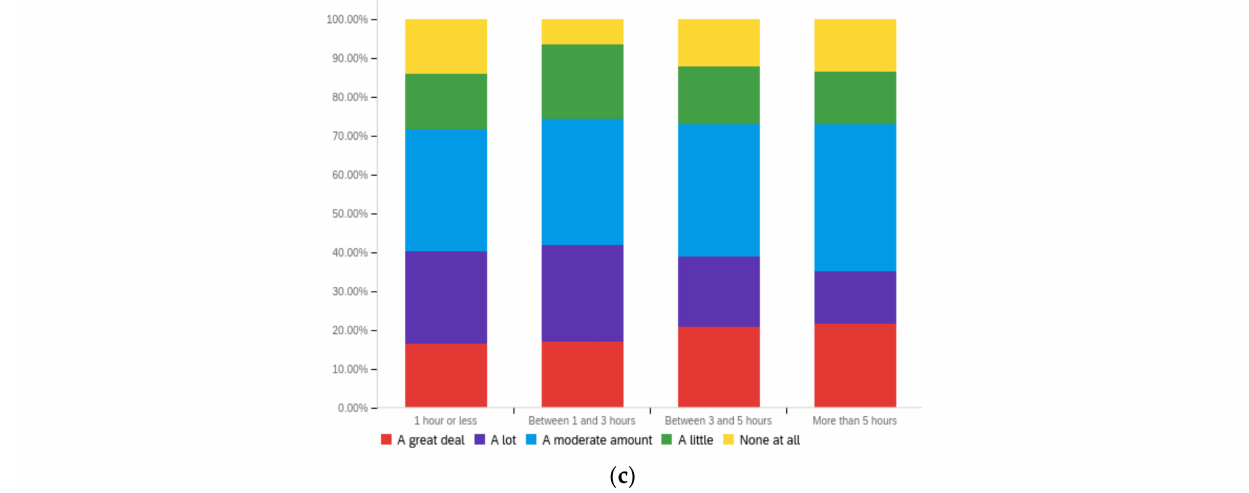
Figure A35. Article reading level—others’ perception impact by: ( a ) income level (top left), ( b ) politi- cal affiliation (top right) and ( c ) online usage (bottom).